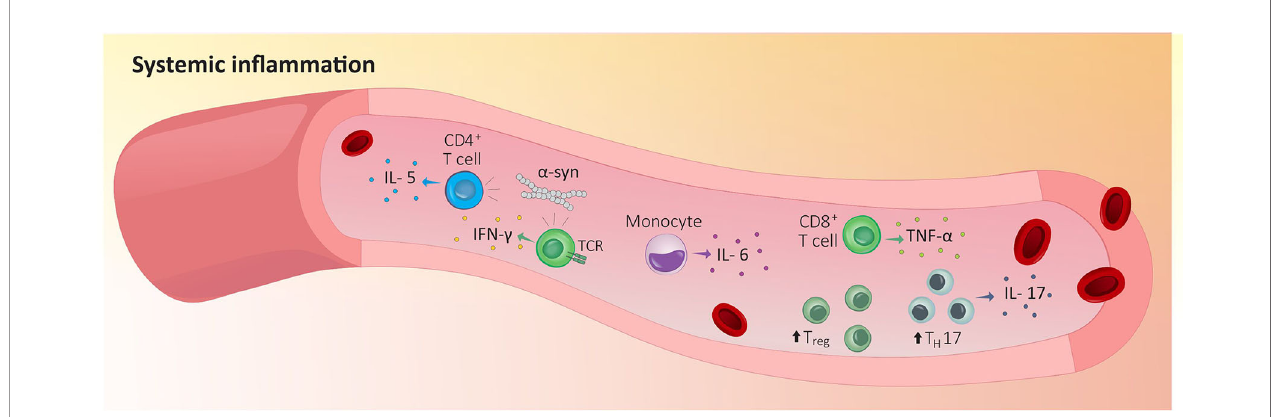
FIGURE 1 | Peripheral in fl ammation in Parkinson ’ s disease. Indicators that the immune system is responding to tissue damage stems from increased blood- circulating